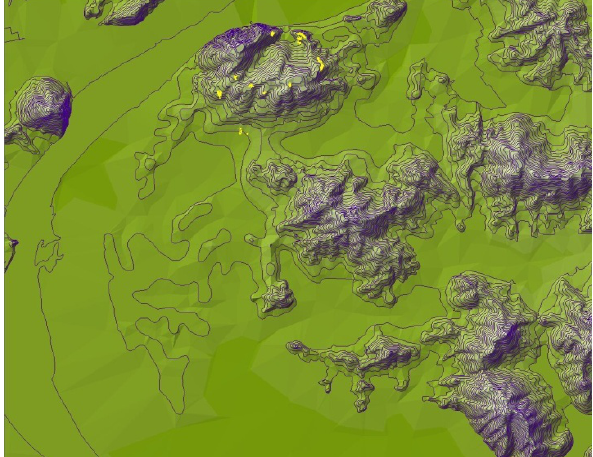
Figure 5. A restoration model of the ancient